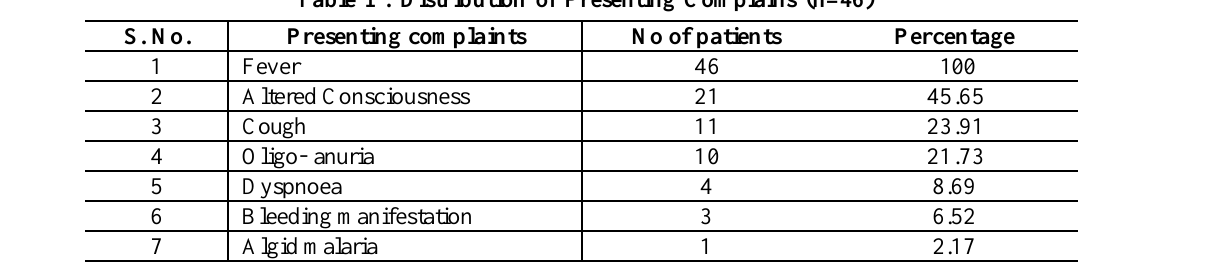
Fig.2 : Bar diagram depicting the duration of Fever in days. Table I : Distribution of Presenting Complains (n=46)